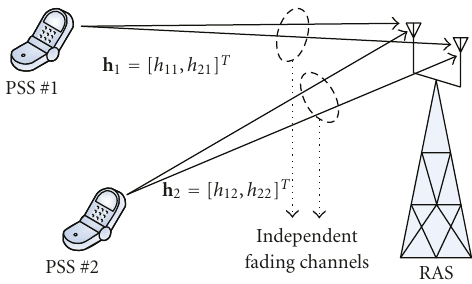
Figure 1: Uplink virtual MIMO